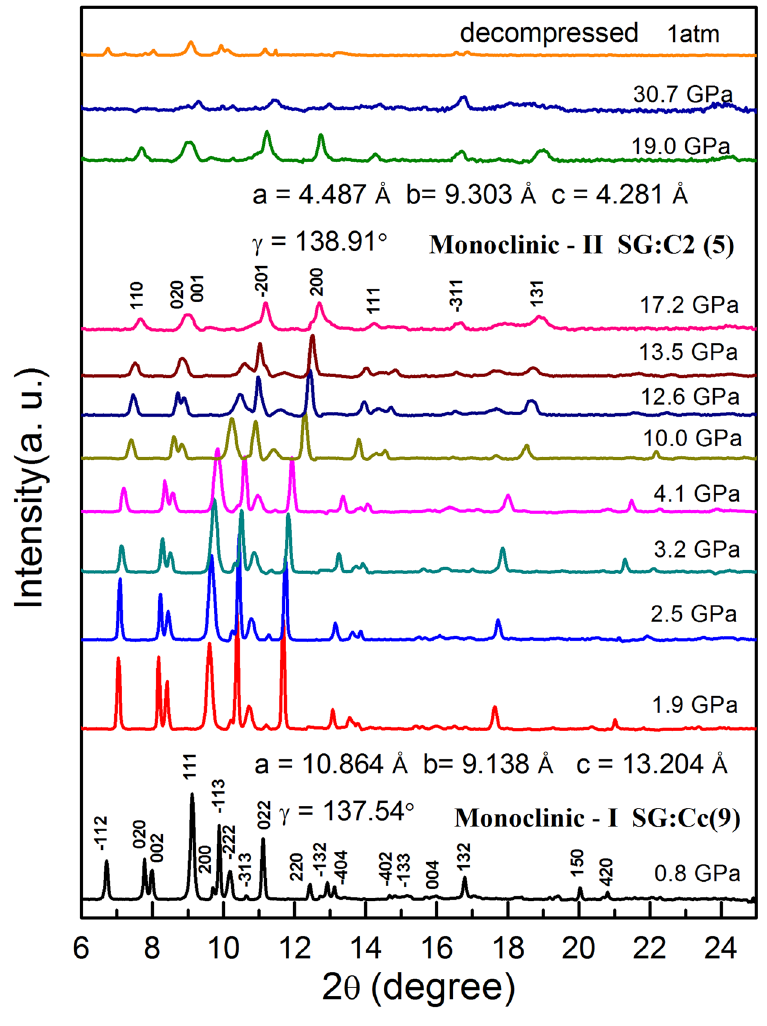
Figure 3. Pressure evolutions of the X-ray diffraction patterns of p -xylene up to 30.7 GPa. The Bragg peaks’ indexes and the cell parameters at 0.8 and 17.2 GPa are shown in the figure,